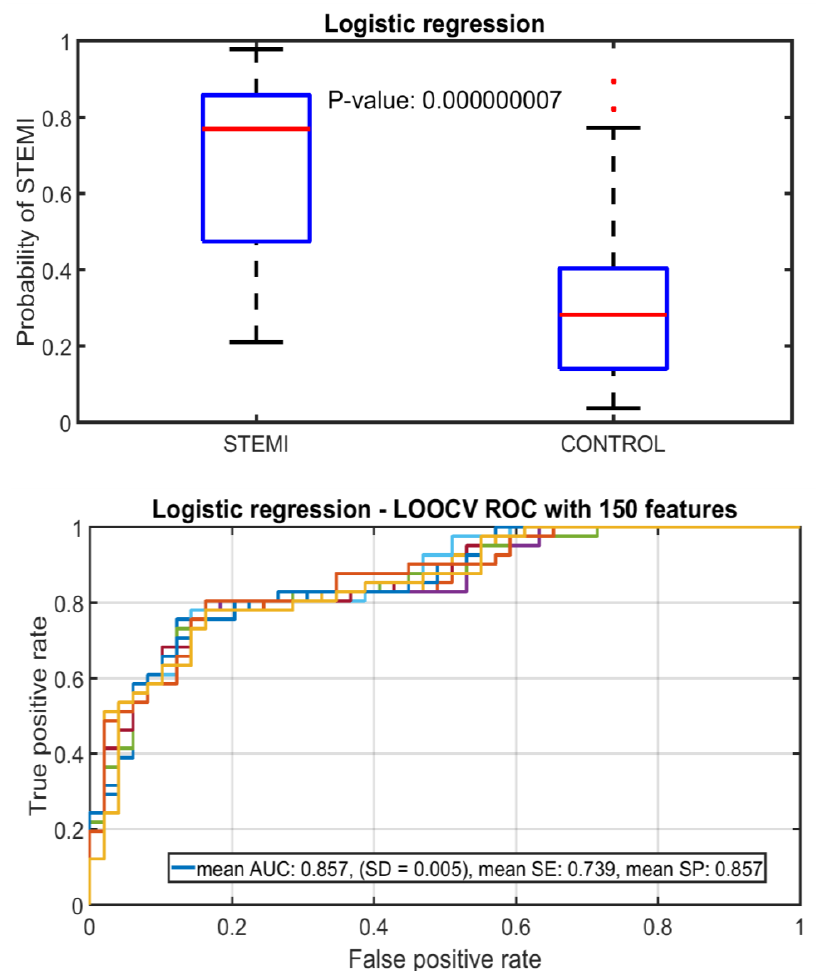
Figure 4. Box plot and receiver operating characteristic (ROC) curve with 150 best features using logistic regression classifier to separate STEMI and control